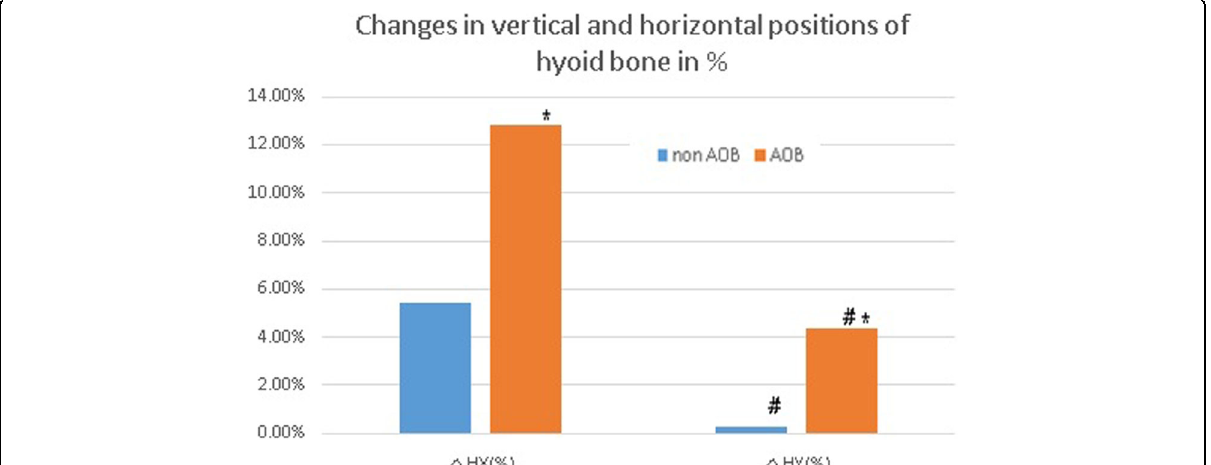
Fig. 5 Vertical and horizontal changes of the hyoid bone location. The hyoid bone was displaced backward and downward in both the groups. Vertical and horizontal changes in the hyoid bone positioning in the AOB group showed statistical significance (* p = 0.022 and * p = 0.028), and there was a statistically significant difference between the two groups in terms of vertical displacement of the hyoid bone ( # p =